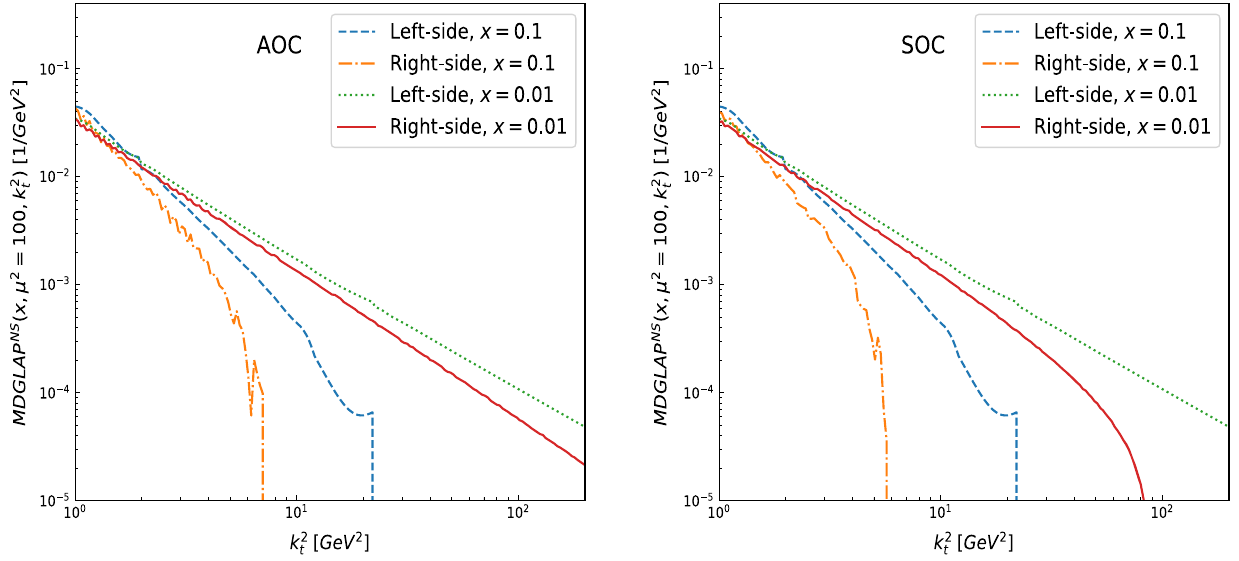
Fig. 2 The left (right) panel shows the comparison of the left and right hand sides of the modified MDGLAP for the non-singlet quark distribution with the AOC